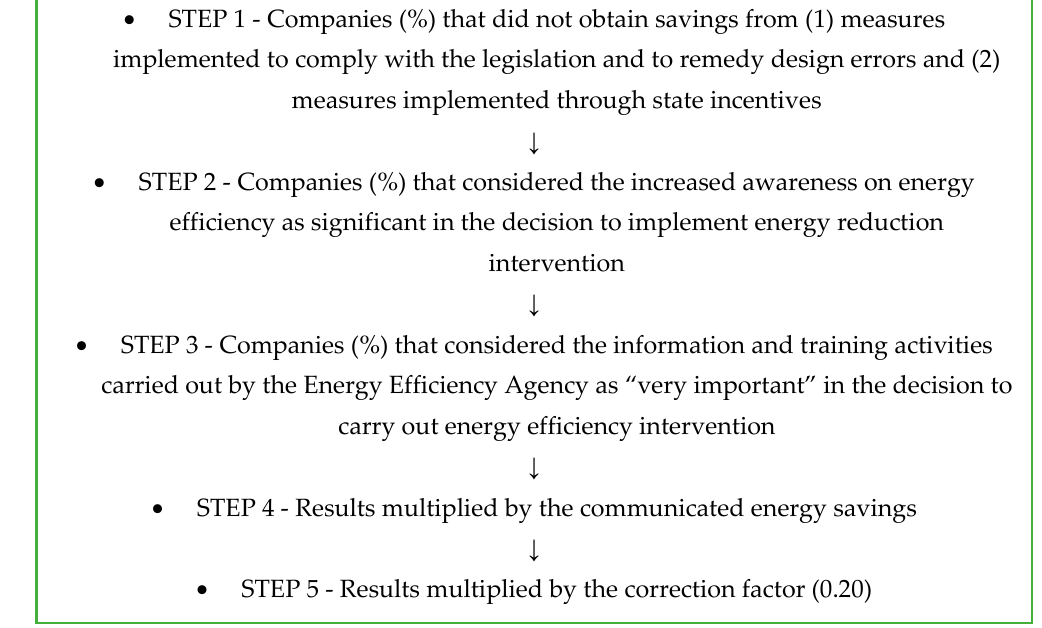
Figure 1. Evaluation process of energy savings from the Italian information and training programme in industry.